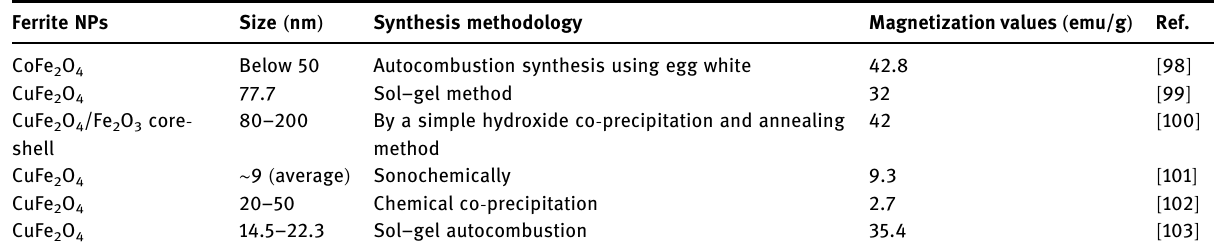
Table 1: Some synthesis methodologies of ferrite NPs and their magnetization values Ferrite NPs Size ( nm ) Synthesis